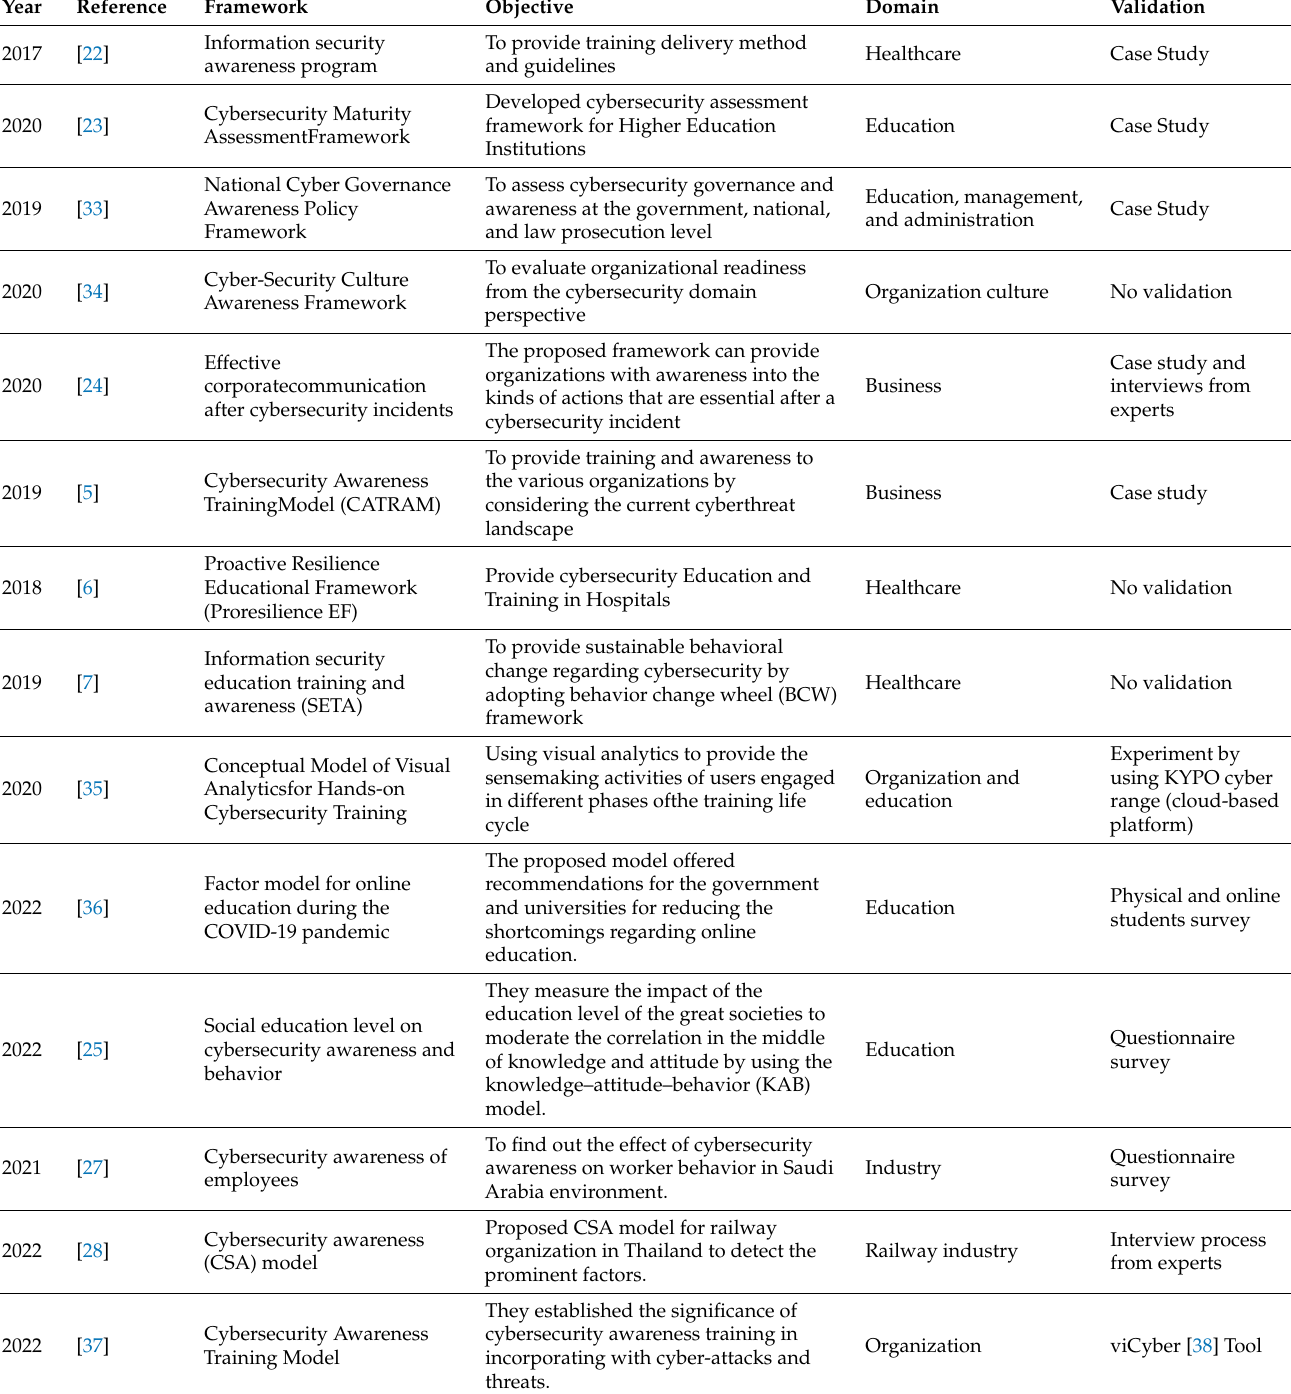
Table 1. The current cybersecurity awareness and training